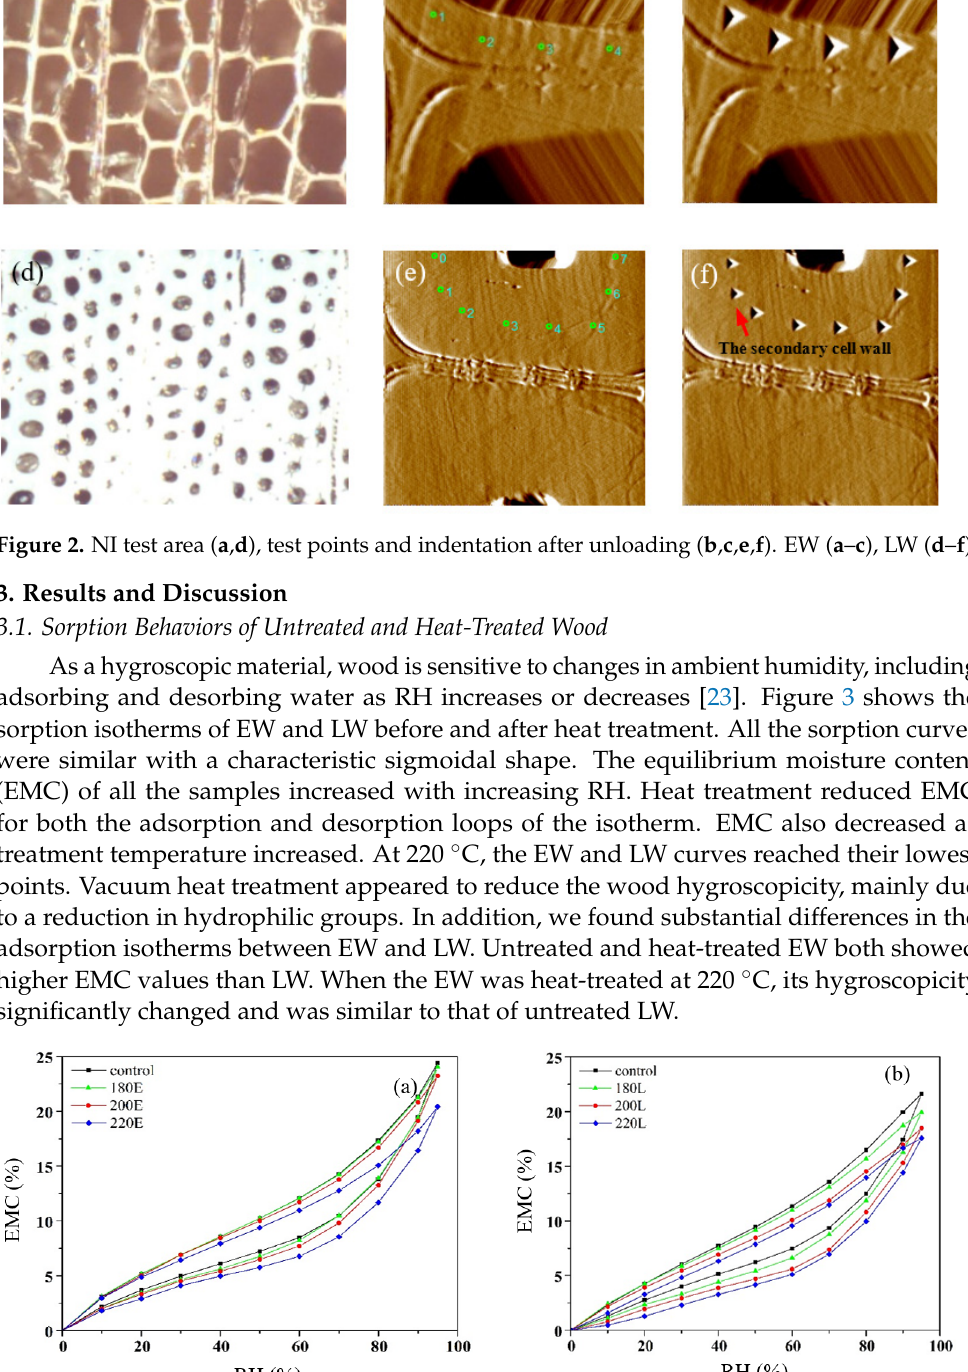
Figure 4. Sorption hysteresis of untreated and vacuum heat-treated EW ( a ) and LW ( b ). The adsorption isotherm data of untreated and heat-treated EW and LW was curve-fitted using the H-H model. The fitting degree was above 0.996 (Table 1). We deconvoluted the sig- moidal isotherms into monolayer ( M h ) and polylayer ( M d ) water, as shown in Figures 5 and 6, where it is apparent that heat treatment reduced the M h and M d of wood. Unlike in EW, heat treatment significantly decreased the monolayer water in LW, reaching equilibrium at lower RH with increasing treatment temperature. The intersection of monolayer and polylayer wa- ter curves for LW also markedly decreased at lower RH; when RH was higher than the inter- section point, polylayer water comprised the majority of the water in the sample. Table 1. Hailwood-Horrobin fitting parameters. Sample